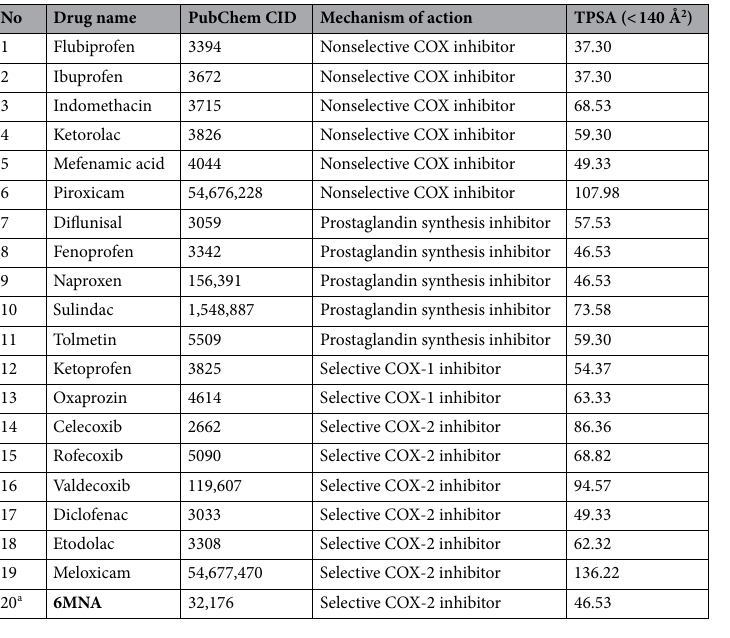
Table 1. A list of NSAIDs (19 active drugs and one prodrug) approved by FDA and TPSA (Å 2 ) values. a 6MNA (Active form) of Nabumetone (Prodrug); TPSA (Topological Polar Surface Area).